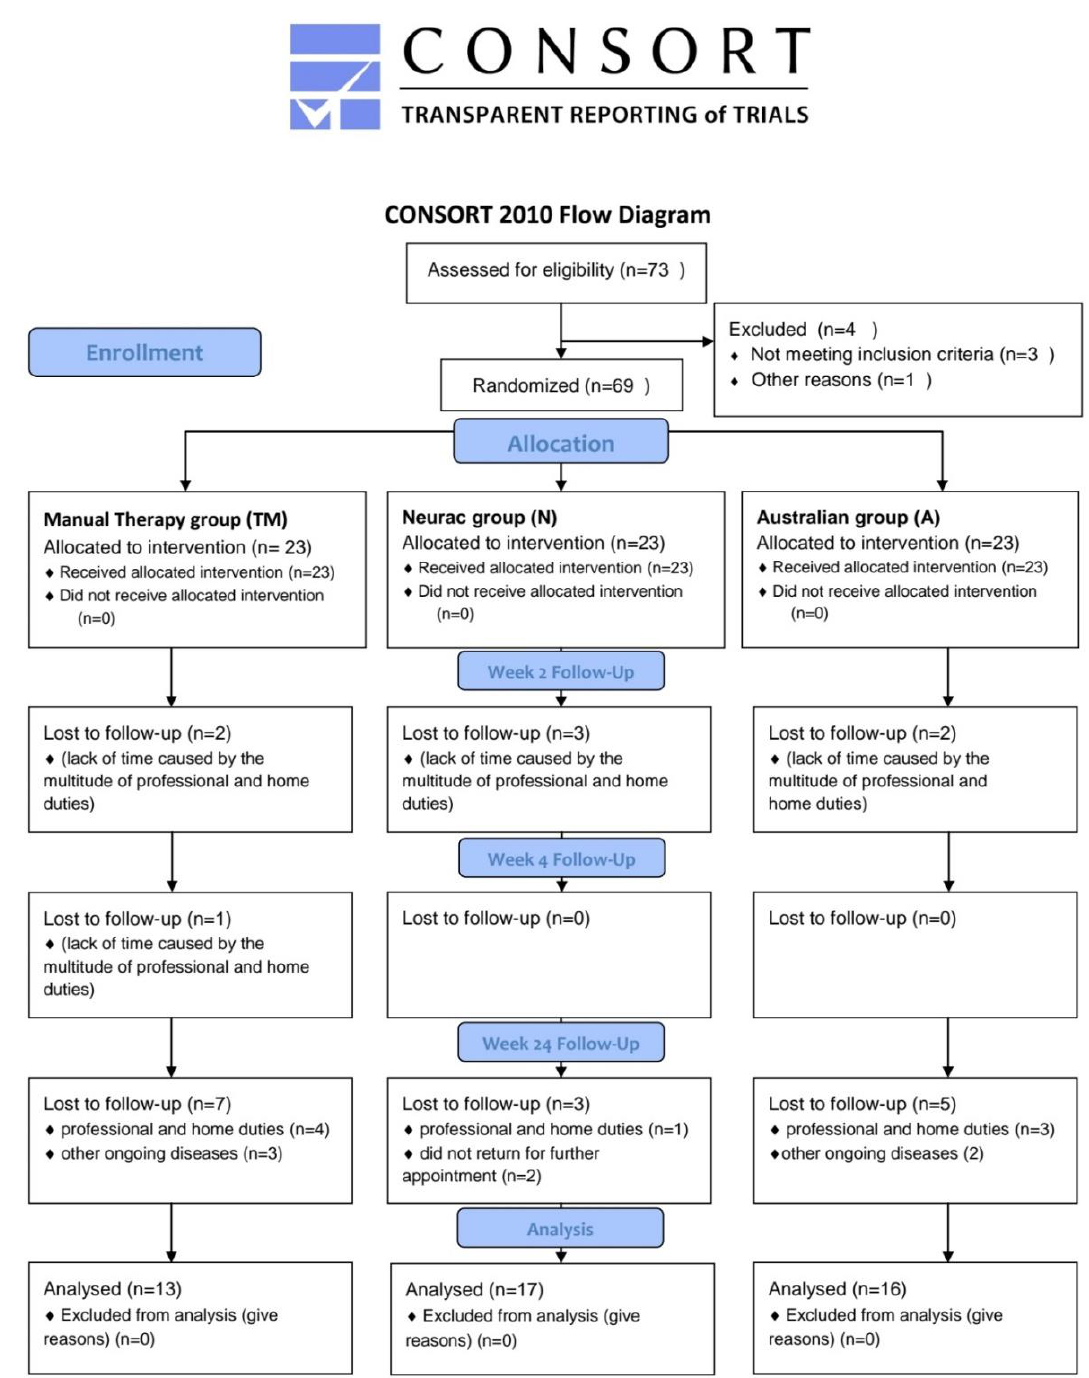
Figure 1. Transparent reporting of trials—CONSORT Flow Diagram.